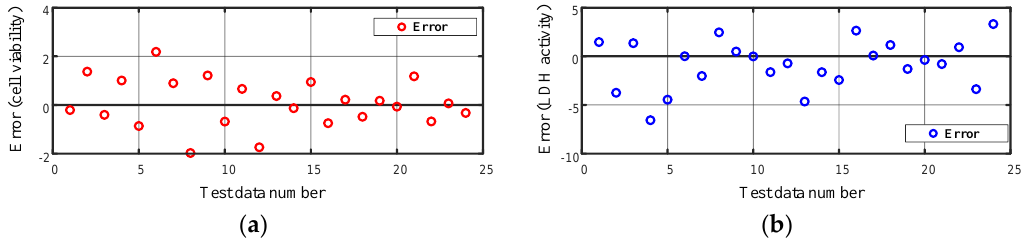
Figure 14. Error in modeling the ( a ) cell viability and ( b ) LDH activity on the test data using the artificial neural